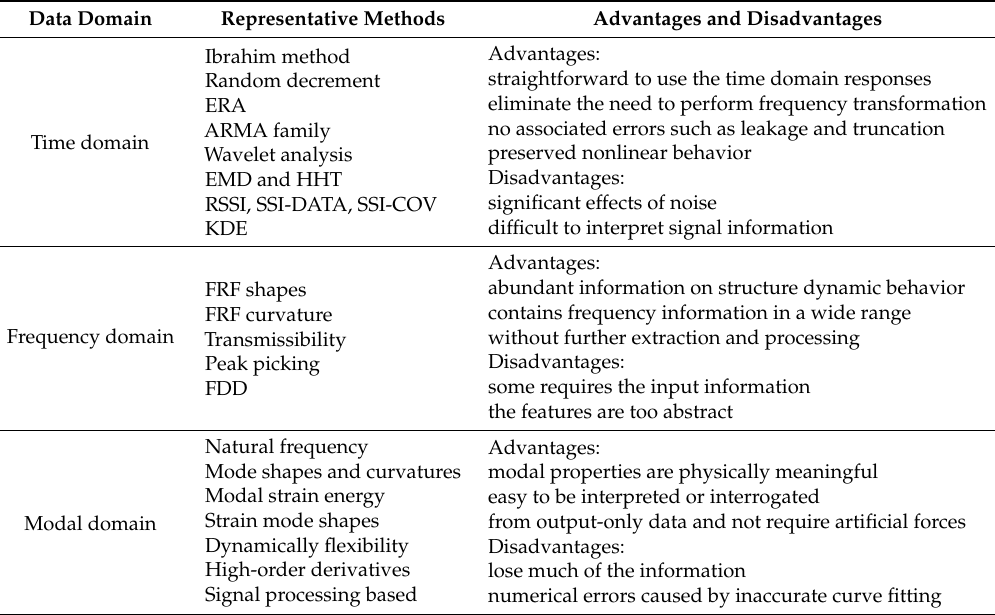
Table 1. Guideline of Response-based